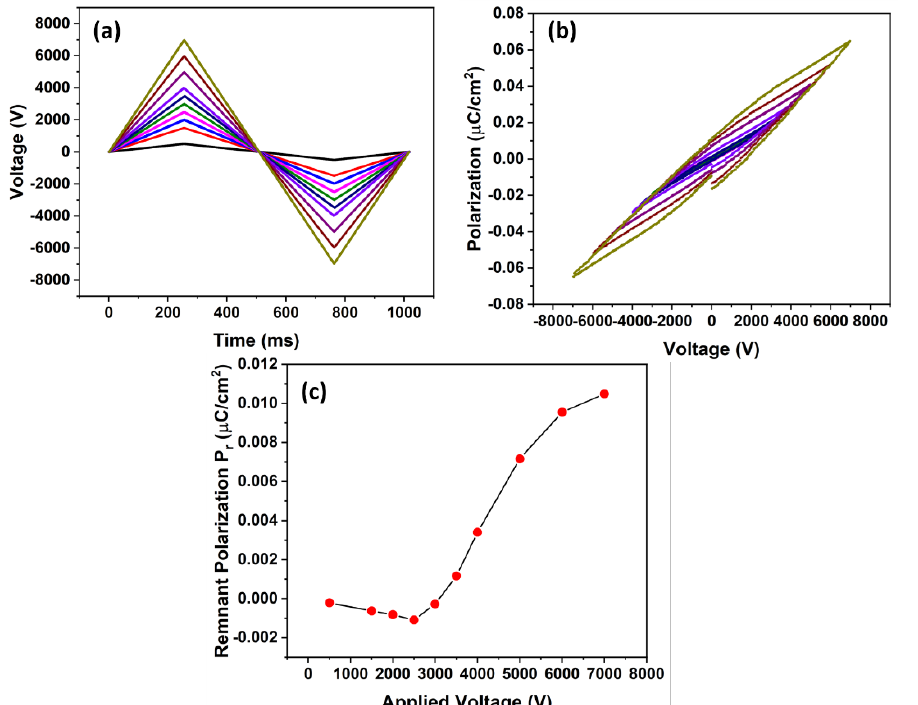
Figure 7. ( a ) Applied voltage over time on the sample ( b ) Hysteresis loop of the prepared sample ( c ) Quasi-permanent charge build up in the micropillar-based COC piezoelectret.